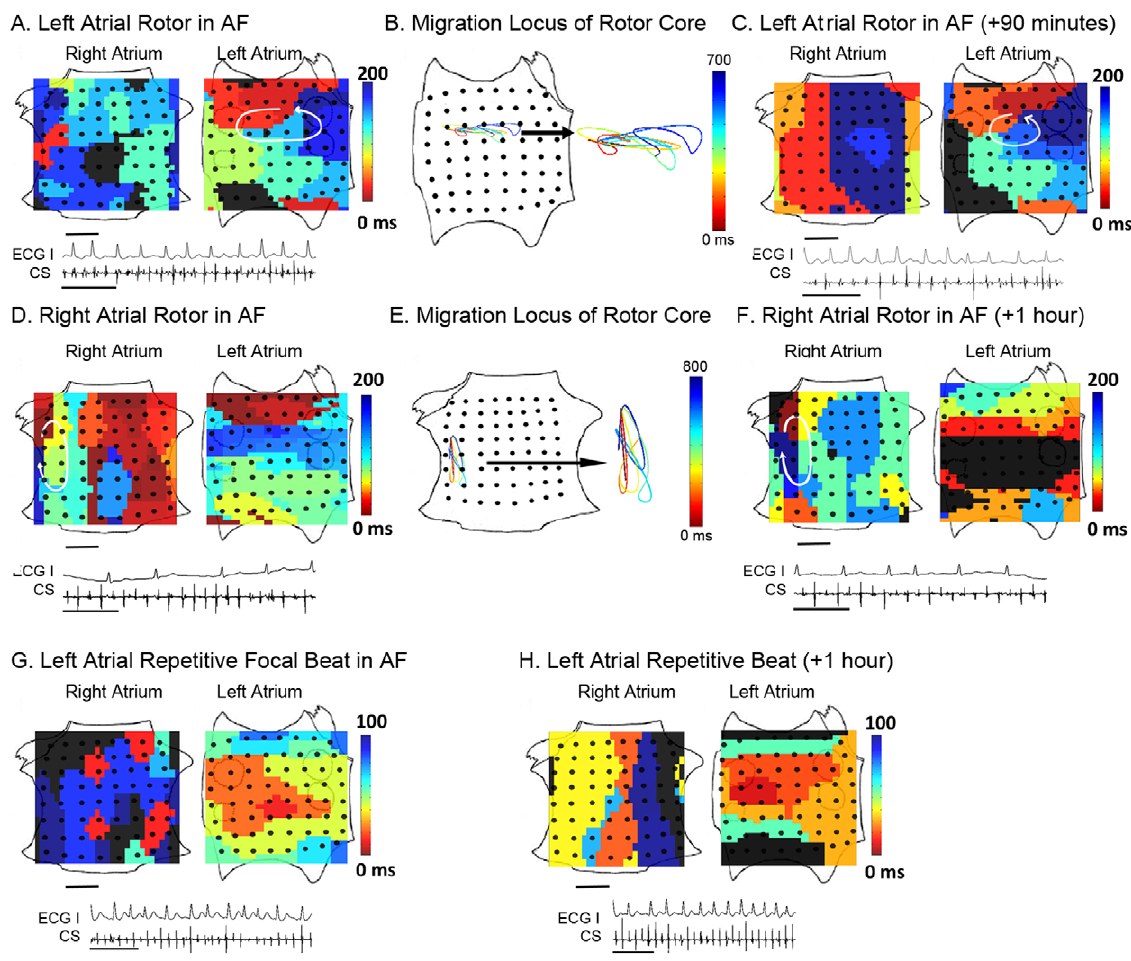
Figure 2. Stable Localized sources underlie human atrial fibrillation. A . Isochrones show an LA rotor in paroxysmal AF, with electrograms during AF (ECG lead I and CS electrodes; scale bar 1 second). Activation times are color-coded (black indicates non-activated, diastole). B . Spatially constrained migration locus of the rotational center, computed every 25–45 ms and joined using third-order Be´zier curve fitting. C . Isochrones 90 minutes later, indicating temporal conservation of the rotor. D . Isochrones of a RA rotor in persistent AF. E . Migration locus. F . Isochrones 1 hour later. G . LA repetitive focal beat in paroxysmal AF. H . Conservation of focal beat 1 hour later. In each case, ablation only at the source locus terminated AF within , 5 minutes. Scale bar 1 cm.